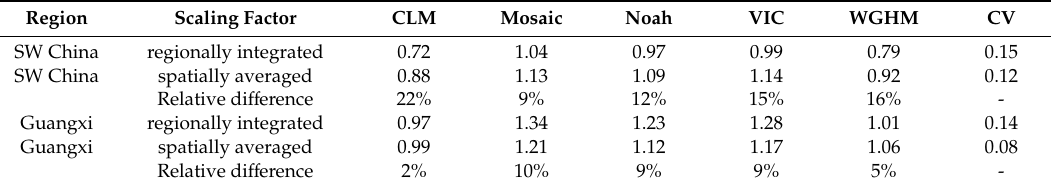
Table 2. Regionally integrated and spatially averaged scaling factors in SW China and Guangxi. Relative di ff erence is defined as the absolute relative di ff erence in scaling factor between the regionally integrated and spatially averaged approaches with respect to the scaling factor for the regionally integrated